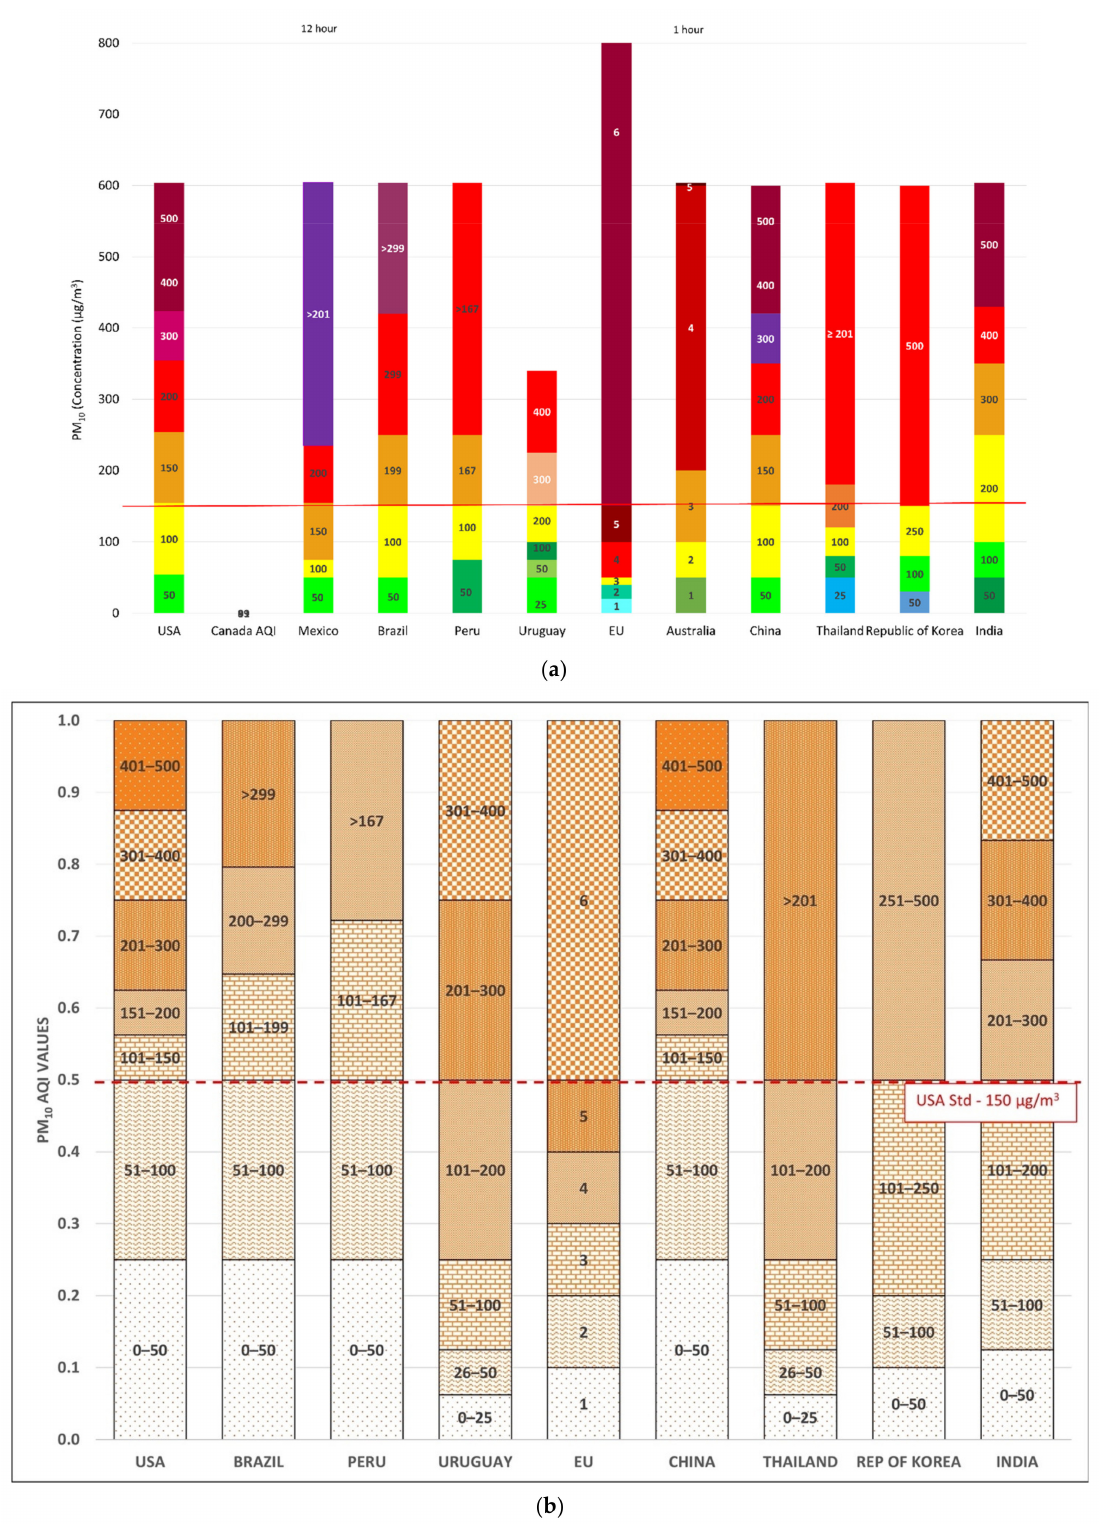
Figure 3. ( a ) PM 10 concentration associated with AQI classes in different countries (above the bars, the averaging periods when different from 24 h). The red line represents the USA standard value. ( b ) Normalized PM 10 AQI values (based on 24-h averaged